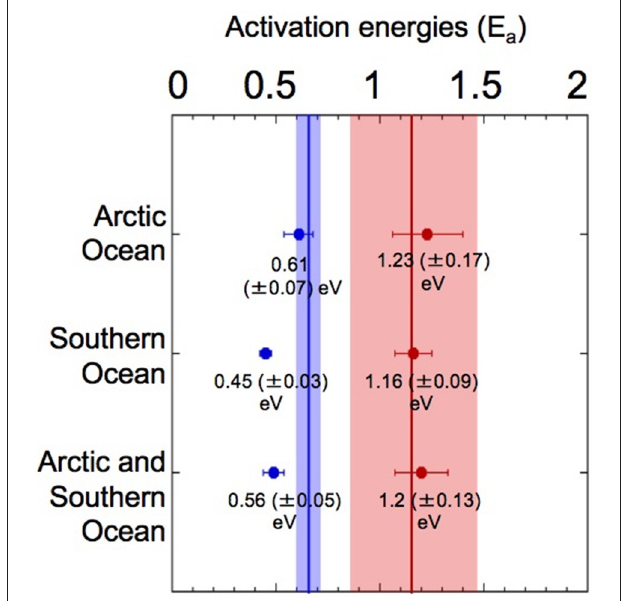
FIGURE 5 | Activation energies (E a ) for phytoplankton growth in the Arctic and Southern Oceans. Analysis of E a for the rise and fall traits estimated from the thermal performance curves of growth-vs.-temperature for phytoplankton communities living in polar oceans. Vertical lines mark the mean E a (shaded areas represent ± 95% CI) of rise (blue) and fall (red) responses, as determined in Dell et al. (2011) (0.65 eV, and 1.15 eV, respectively) for an entire dataset, including microbes, plants and